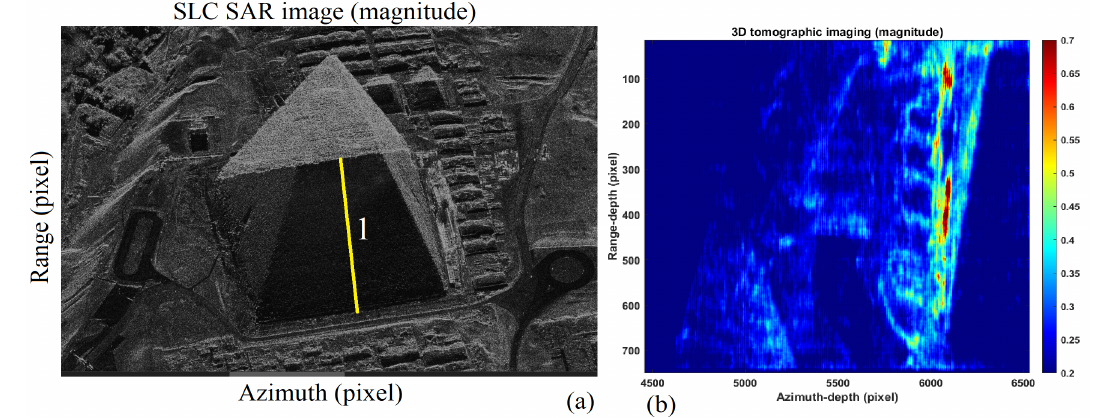
Figure 35. SAR images. ( a ): SLC SAR image (magnitude). The tomographic line 1 is oriented along the Western-side of the pyramid. ( b ): Tomographic result (magnitude).